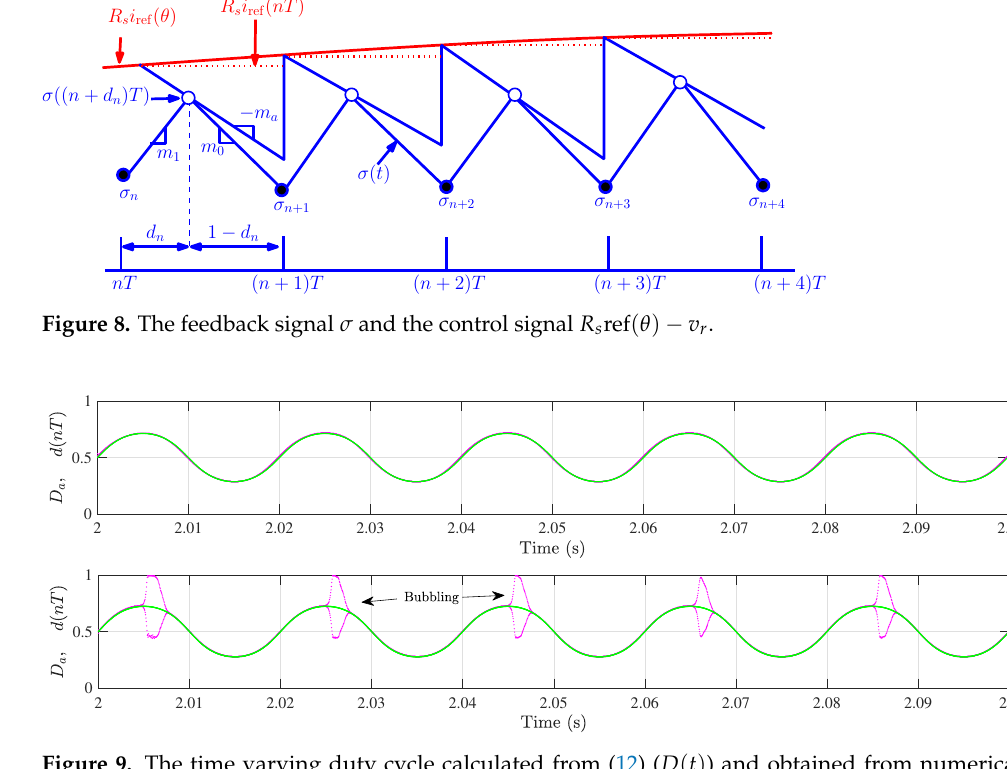
Figure 9. The time varying duty cycle calculated from (12) ( D ( t ) ) and obtained from numerical N ) for S = 1000 W/m 2 and S = 200 W/m 2 simulation ( d ( nT ) , n ∈